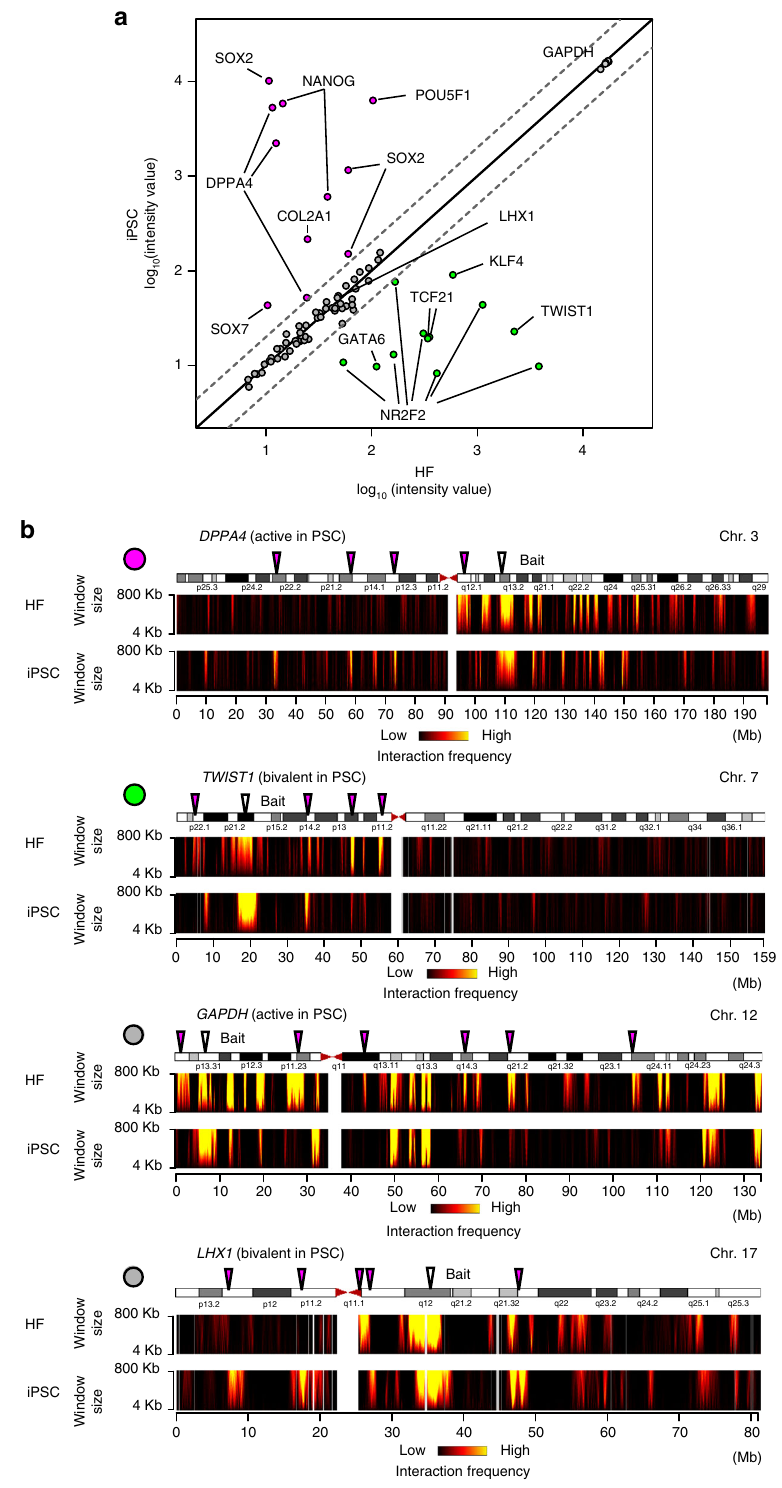
Fig. 3 Chromatin interaction pro fi les at bivalent gene loci in somatic cells and hPSCs. a Expression pro fi les of bait genes in iPSCs and their original HFs (HDFs). The scatter plot represents the log 10 signal intensity of probe sets for Affymetrix GeneChip Array (HG-U133_Plus_2). A single gene is sometimes represented by multiple probe sets corresponding to different isoforms and ESTs derived from the same gene locus. Thus, some genes have multiple dots (probe sets). Two dashed lines indicate the two-fold changes in gene expression levels between HFs (HDFs) and hiPSCs. The dots are color-coded as category 1 (magenta), category 2 (green), and category 3 (gray) on the basis of the fold change of the signal intensity. b Cis -chromosomal interaction pro fi les of the bait loci ( DPPA4 , TWIST1 , GAPDH , and LHX1 ). The interaction frequencies of baits are shown by domainograms 37 . DPPA4 and GAPDH are active genes in PSCs. TWIST1 and LHX1 are bivalent genes in PSCs. The arrowheads indicate bait loci (white) and representative interaction regions that differ between HFs (HDFs) and hiPSCs (magenta). The left upper dots are colored according to the de fi nition in